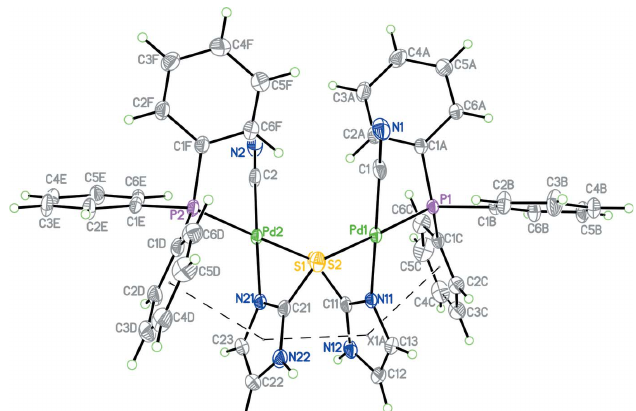
Figure 2 Diagram of 2 showing the atom labeling and the strong intramolecular (cid:4) – (cid:4) interactions involving both the thione rings and adjacent phenyl rings from the triphenylphosphine ligand. Atomic displacement parameters are at the 30% probability level.